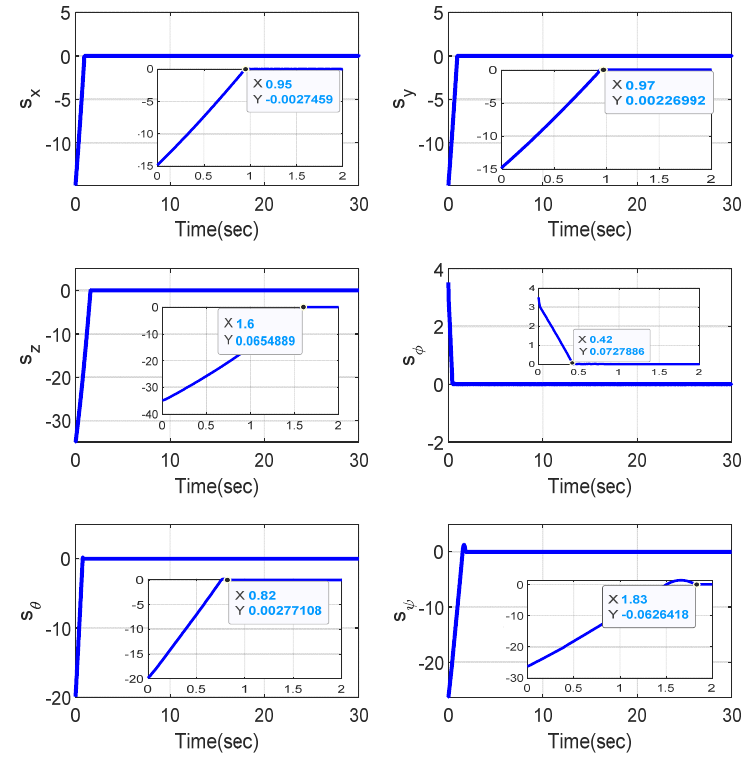
Figure 5. Time histories of the linear sliding surface.